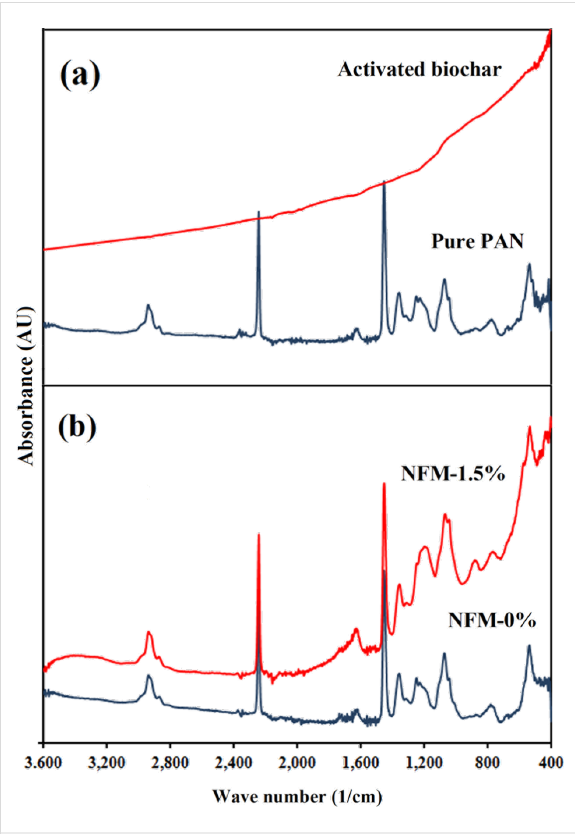
Figure 5: FTIR spectra of (a) pure PAN powder and activated biochar and (b) NFM-0% and NFM-1.5%.